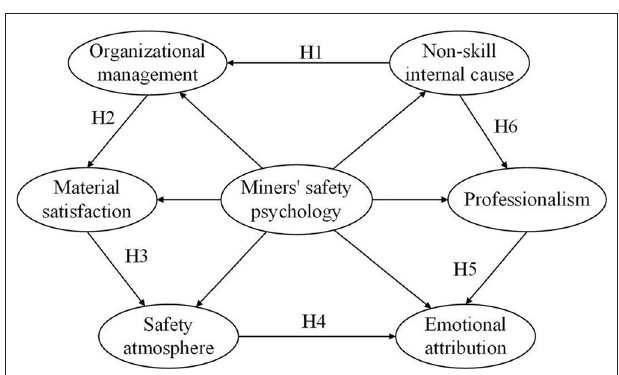
FIGURE 5 | Structural equation diagram of comprehensive